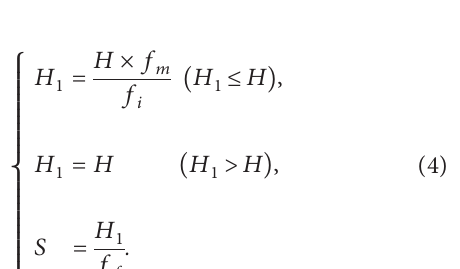
Figure 9: Automatic fault identification